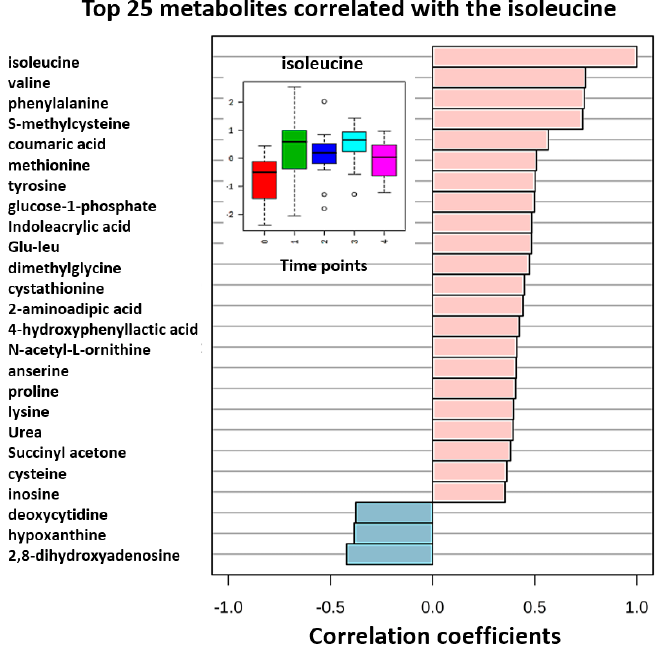
Figure 6. Top 25 metabolites correlating with isoleucine level patterns at time points 0–4 (corresponding to fasting 7 AM, 10 AM, 1 PM, 4 PM, and 7 PM), which correlated to intra-day variation in the blood metabolome analyzed with DBS protocols.